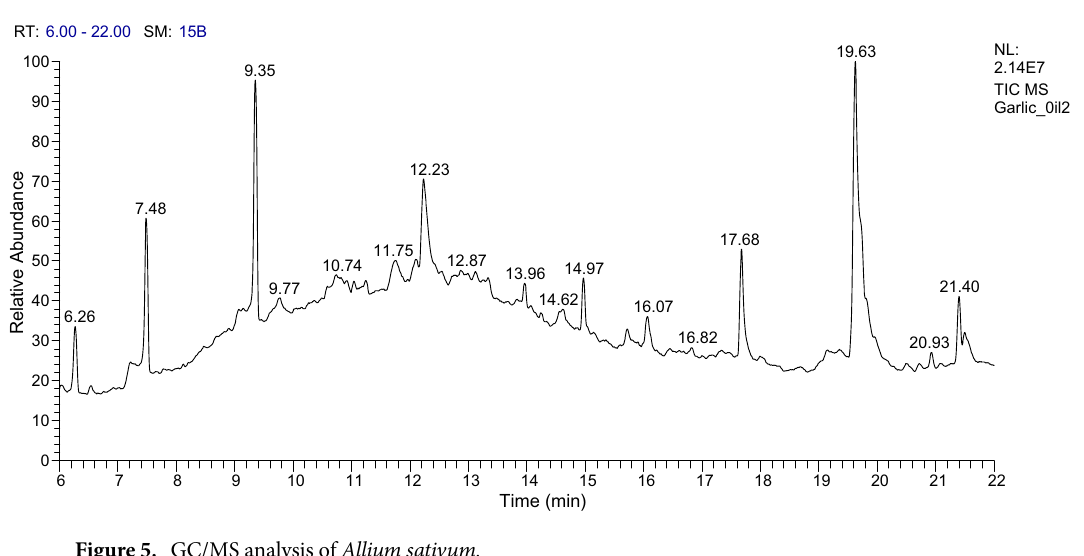
Figure 5. GC/MS analysis of Allium